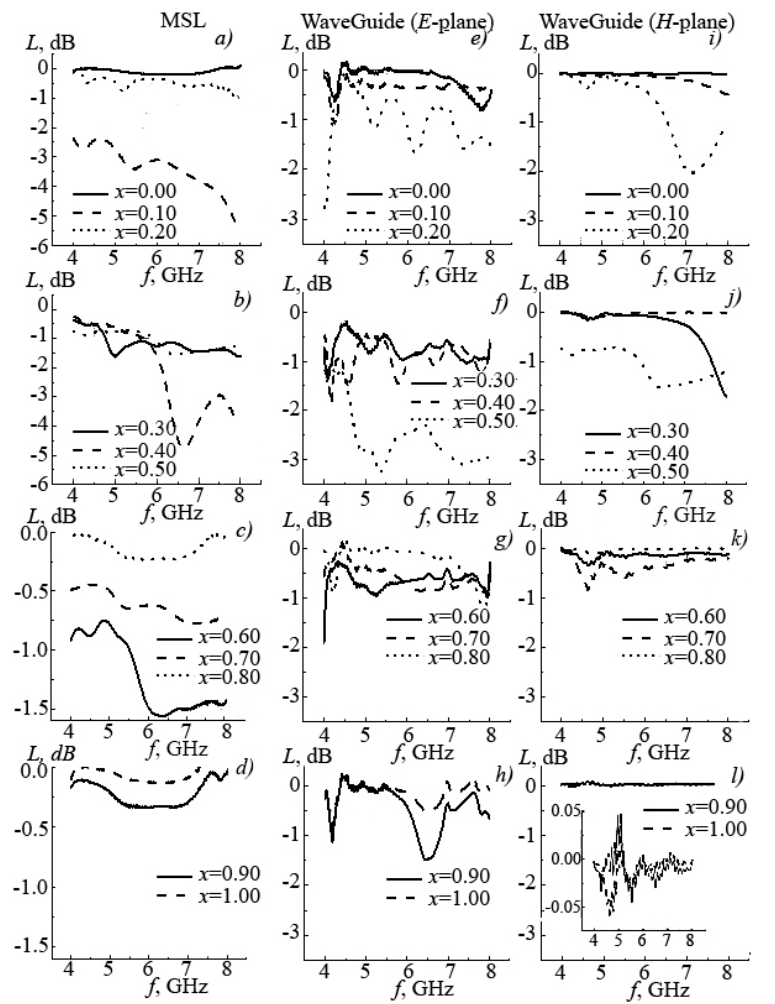
Figure 7. Dependences of microwave absorption on f in SS (1 − x)BaNb 2 O 6 - x SrNb 2 O 6 . (MSL ( a – d ), waveguide line in the E-plane ( e – h ) and H-plane ( i – l )).